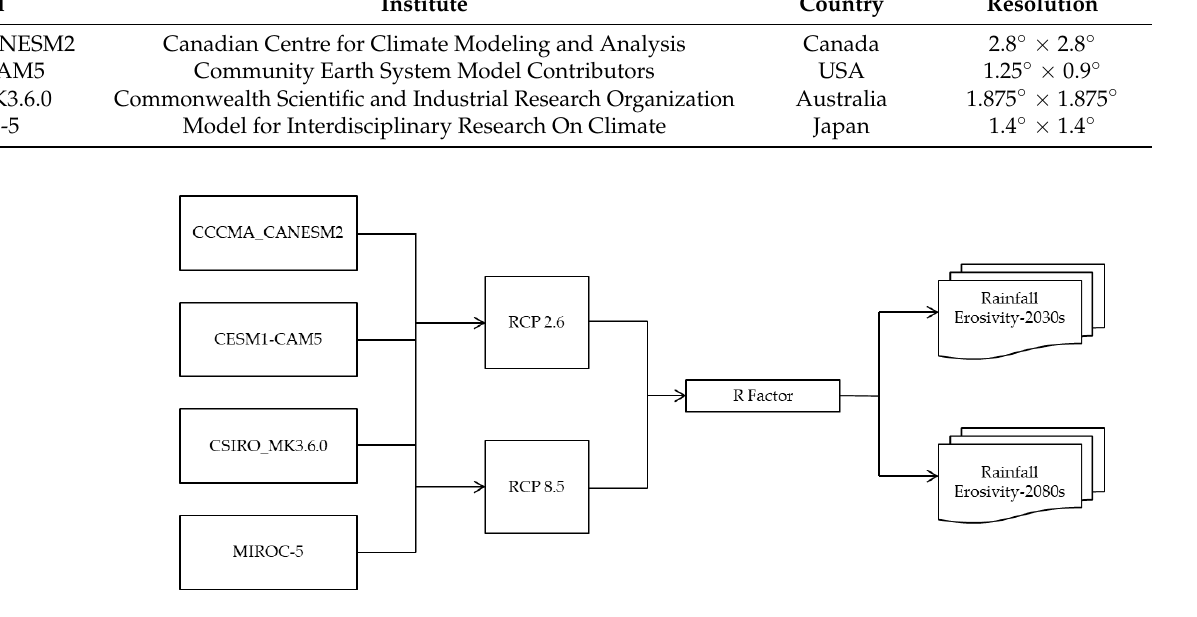
Figure 6. Integration of the climate change scenarios with the R factor used in this study. Table 1. Details of the four GCMs applied in this study.